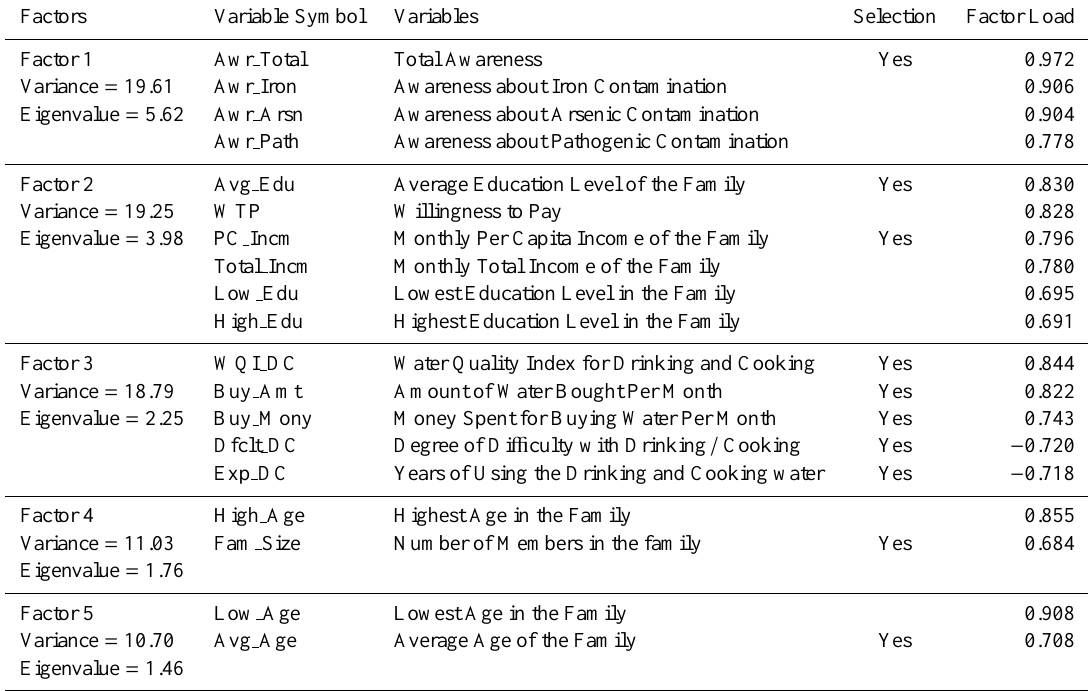
Table 6. Varimax rotated factor loadings for five-factor solutions. Factors